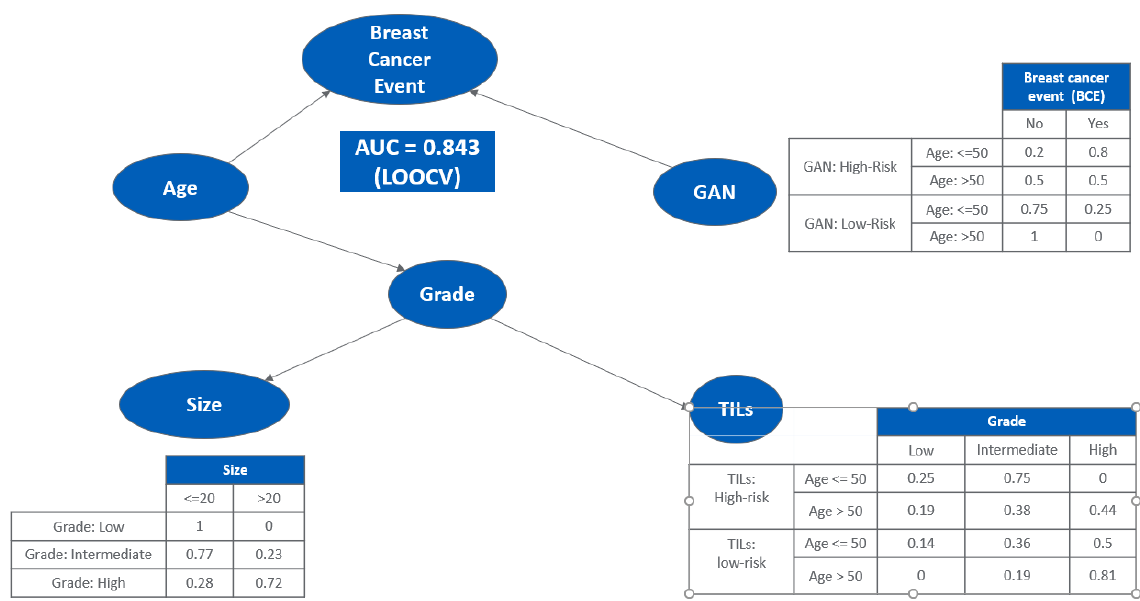
Figure 3. Bayesian network integrating multi-modalities with clinicopathological data and likelihood of BCEs.